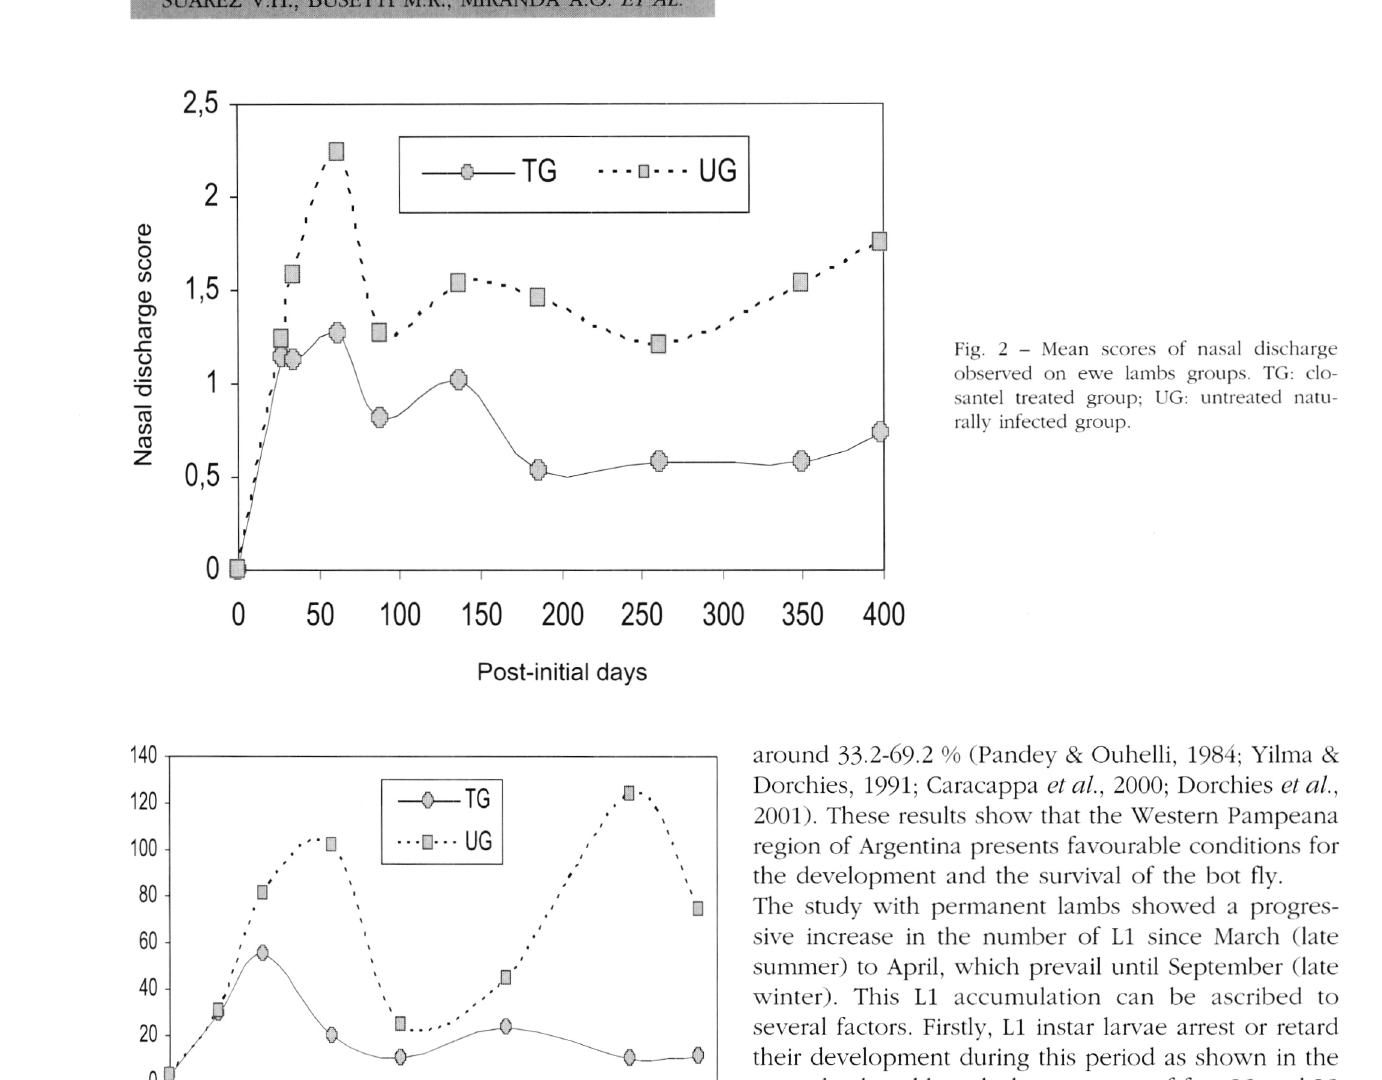
Fig. 3 - ELISA values (expressed as a percentage of antibodies com­ pared to a positive reference serum) observed on ewe lambs groups. TG: closantel treated group; UG: untreated naturally infected